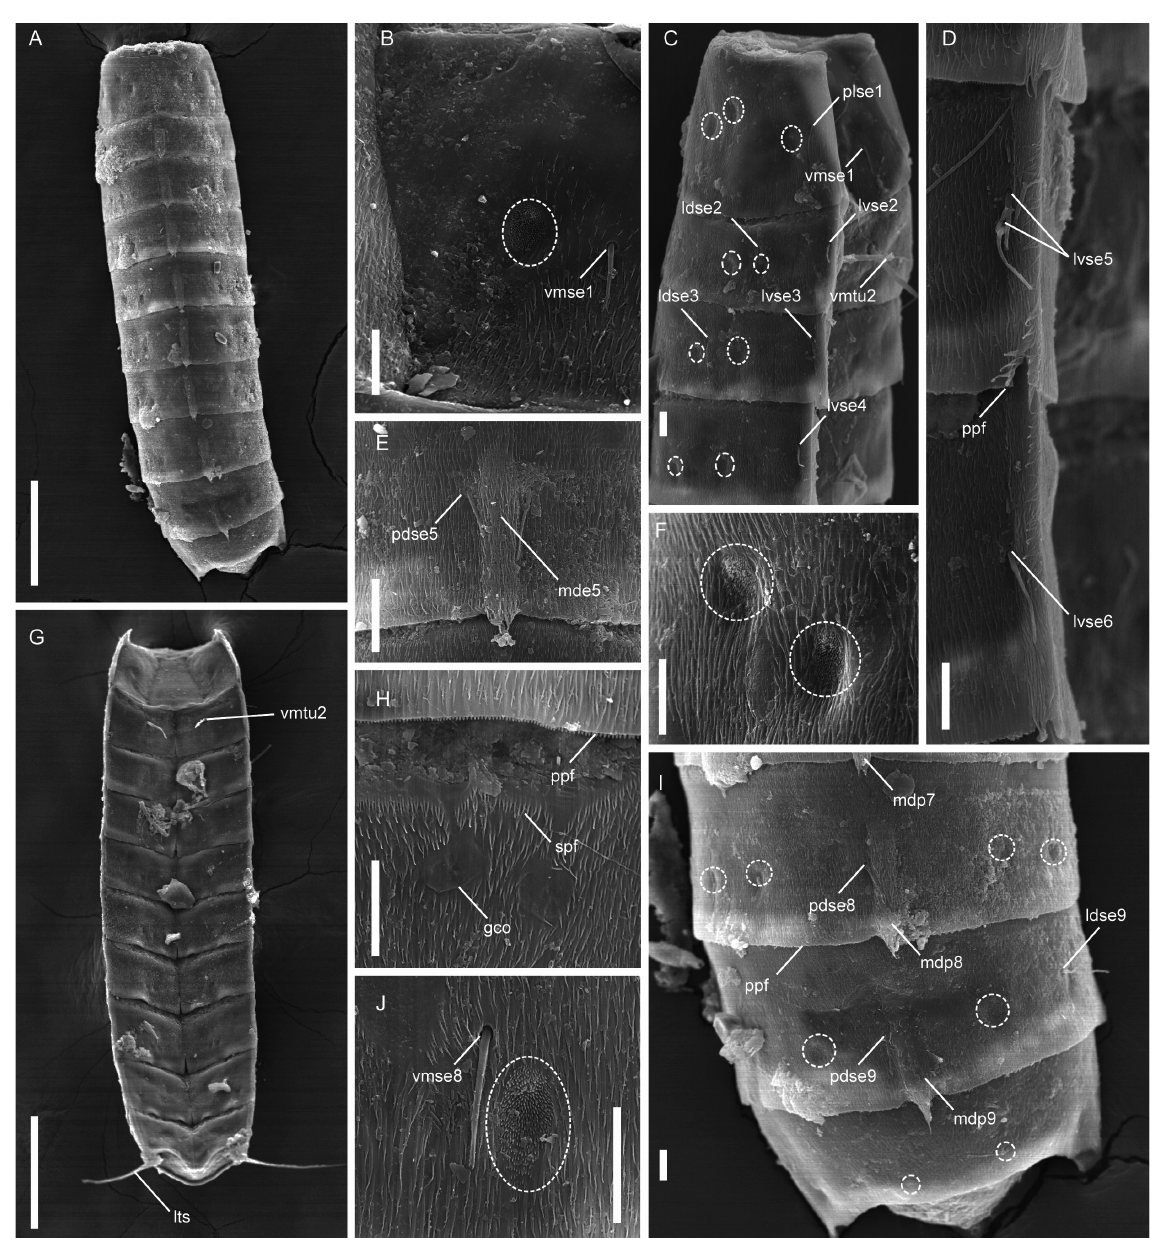
Fig. 4. Scanning electron micrographs showing general overview and details of the cuticular trunk morphology of three adult males, additional specimens of Setaphyes algarvensis sp. nov. (UCM Meiofauna Collection) A . Dorsal overview. B . Ventral view of left half segment 1. C . Lateral view of segments 1–4. D . Ventral view of segments 5–6. E . Middorsal elevation of segment 5. F . Detail of dorsal sensory spots on segment 1. G . Ventral overview. H . Detail of pectinate fringe and glandular cell outlets of segment 8. I . Dorsal view of segments 8–11. J . Detail of ventral seta and sensory spot on segment 8. Abbreviations: gco = glandular cell outlet; ldse = laterodorsal seta; lts = lateral terminal spine; lvse = lateroventral seta; mde = middorsal elevation; mdp = middorsal process; pdse = paradorsal seta; plse = paralateral seta; ppf = primary pectinate fringe; spf = secondary pectinate fringe; vmse = ventromedial seta; vmtu = ventromedial tube; numbers after abbreviations indicate corresponding segment; sensory spots are marked as dashed circles. Scale bars: A, G = 100 µm; B–F, H–J =